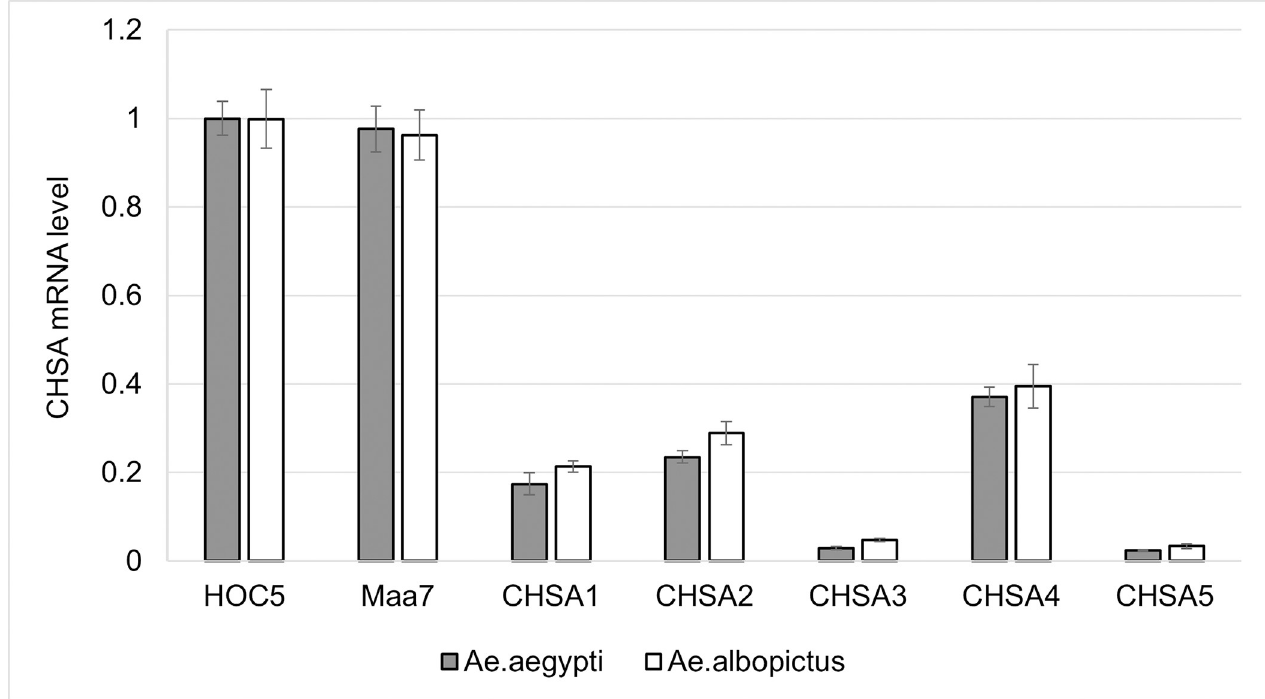
Fig 4. The relative chsa mRNA levels in Aedes L3 larvae fed with recombinant Chlorella. HOC5: larvae fed with wild Chlorella strain HOC5; Maa7: larvae fed with empty plasmid Maa7IR/XIR transgenic Chlorella strain; CHSA1 to CHSA5: larvae fed with recombinant Chlorella strains CHSA1 to CHSA5.